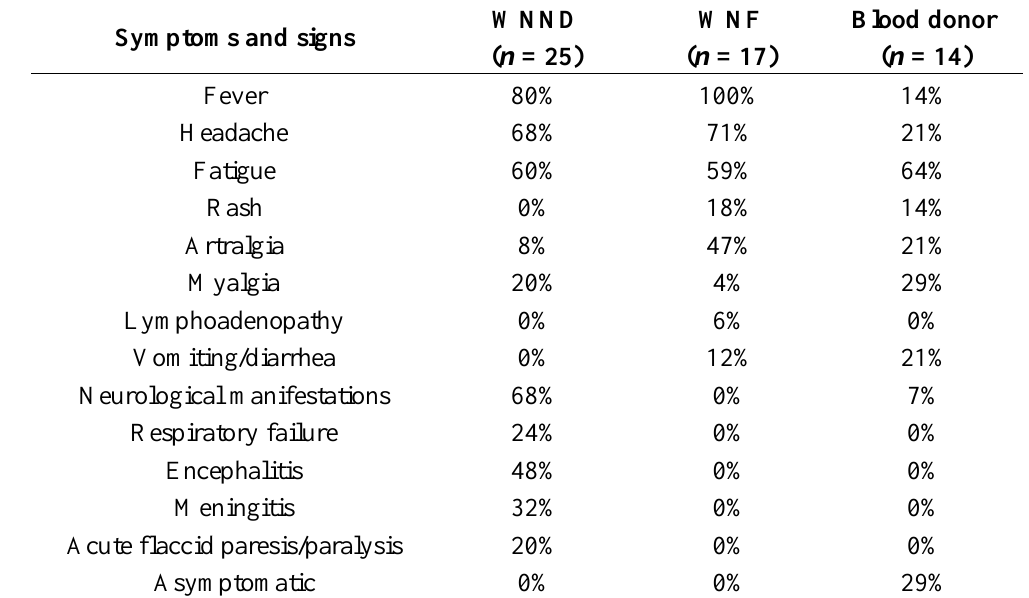
Table 1. Frequency of symptoms and signs in patients with WNV infection, Northeastern Italy, 2012.